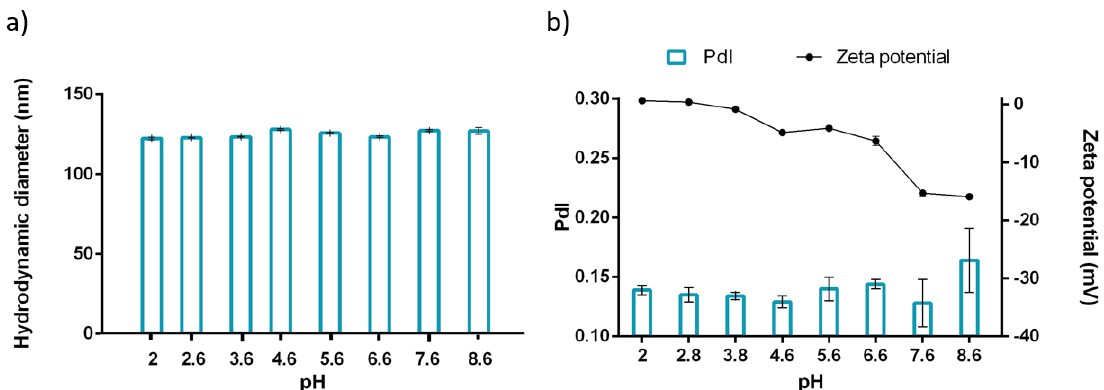
Figure 5. pH stability of NLC-Rho, parameters evaluated by ( a ) Hydrodynamic diameter and ( b ) PdI and zeta potential (mV). n = 3 ± SD.